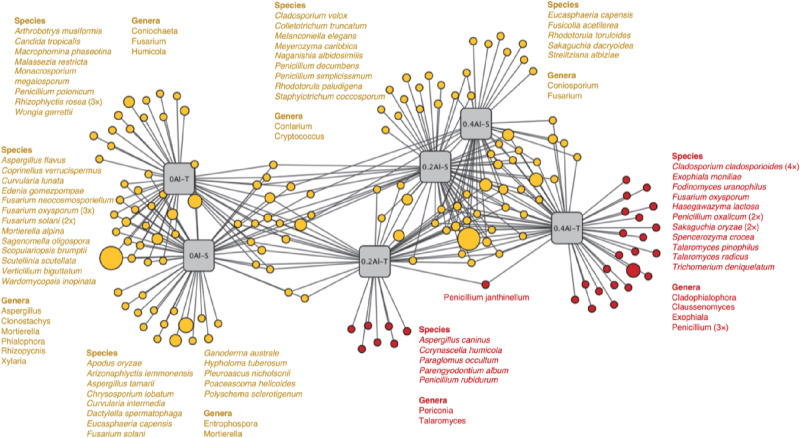
Bipartite association network showing positive associations between the treatment groups and the 163 significantly (q < 0.1) associated OTUs. Node sizes represent relative abundance of the OTUs. Edges represent the associations of individual OTUs with the treatments. The network structure was generated using the edge-weighted (association strength) Fruchterman-Reingold algorithm such that OTUs with similar associations and treatments with similar structure are clustered. Al-T: Al-tolerant soybean genotypes; Al-S: Al-sensitive soybean genotypes.